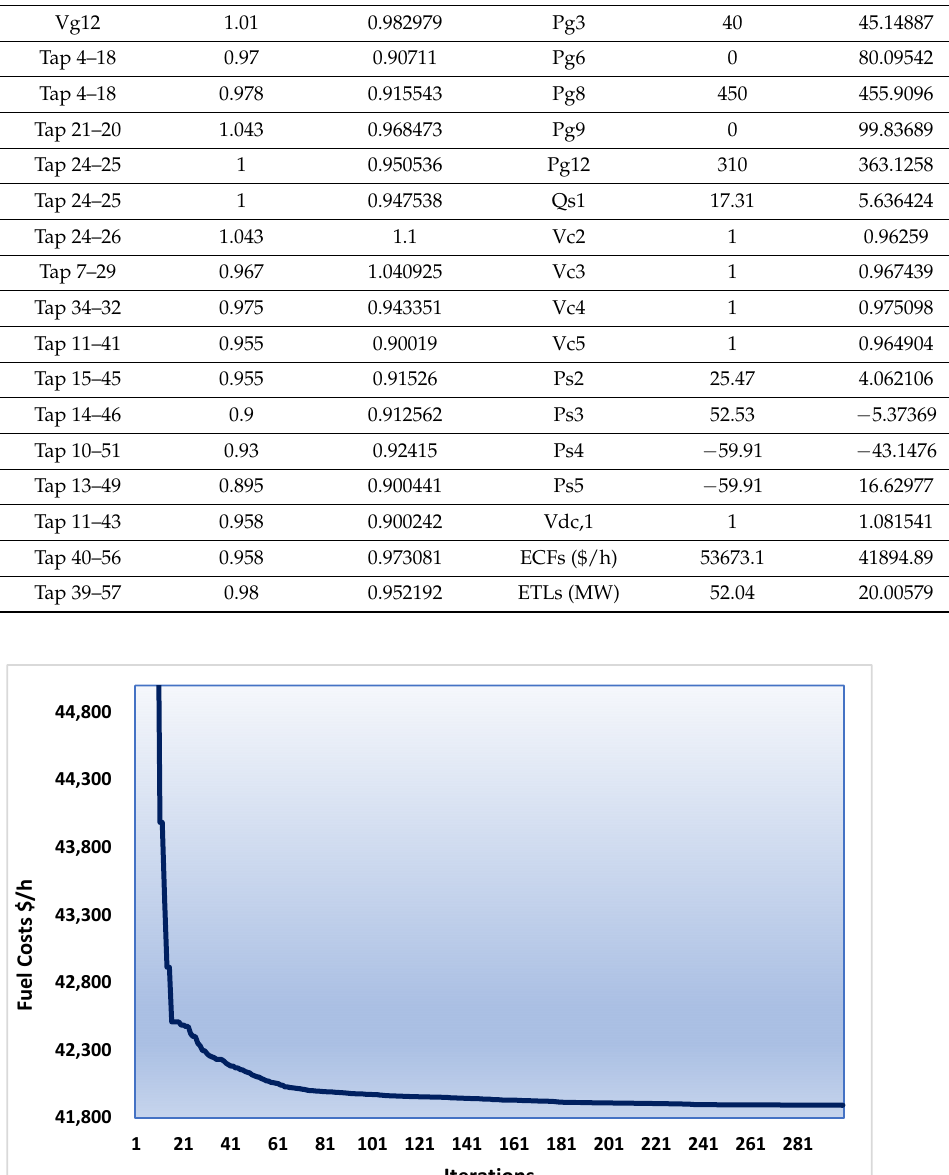
Table 7. Simulation results of TLBA for the minimization of the TFCs of the IEEE 57-bus network. Variables